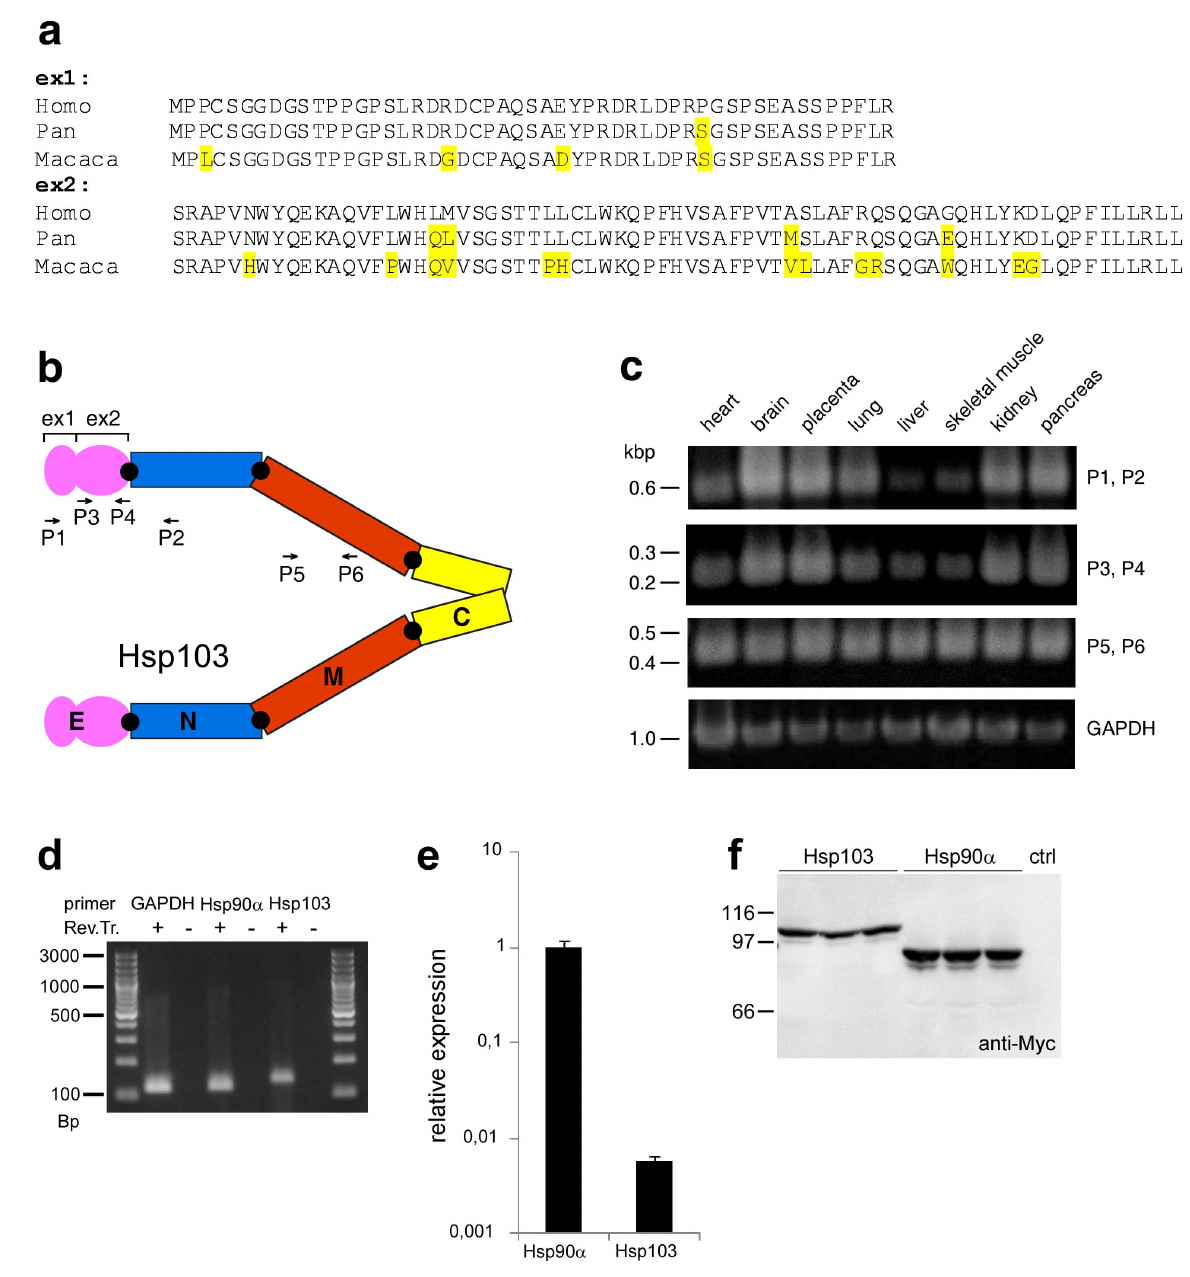
Figure 1. The molecular chaperone Hsp103 contains a fourth domain of 122 aa, termed E domain. (a) Alignment of E domain sequences from man (Homo sapiens), chimpanzee (Pan troglodytes) and rhesus macaque (Macaca mulatta). Residues that differ between the species are marked in grey. (b) Four domain structure of Hsp103. The additional 122 aa encoded by the two exons ex1 and ex2 form the E domain. Positions of Primers (P1–P6) used for PCR analysis are indicated. (c) Amplification of Hsp103 from a human multiple tissue cDNA panel. Primers P1, P2 amplify a contiguous sequence covering the E domain and parts of the N domain. P3, P4 amplify ex2 of Hsp103 and P5, P6 amplify a sequence in the M domain present in Hsp90 a and Hsp103. GAPDH is shown as a control. (d) The three primer probes used for qPCR produce single bands for GAPDH, Hsp90 a and Hsp103 indicating their specificity. No signals were visible on samples without Reverse Transcriptase (Rev. Tr.), confirming the absence of contaminating genomic material. (e) Expression of endogenous Hsp103 mRNA is below 1% compared to Hsp90 a on a logarithmic scale as revealed by qPCR. (f) Expression of Hsp103 and Hsp90 a with N-terminal Myc-tag from the pCMV plasmid in HEK293 cells. Transfections were done in triplicate; control cells received empty vector. Proteins were visualized by Western blotting with the Myc specific antibody